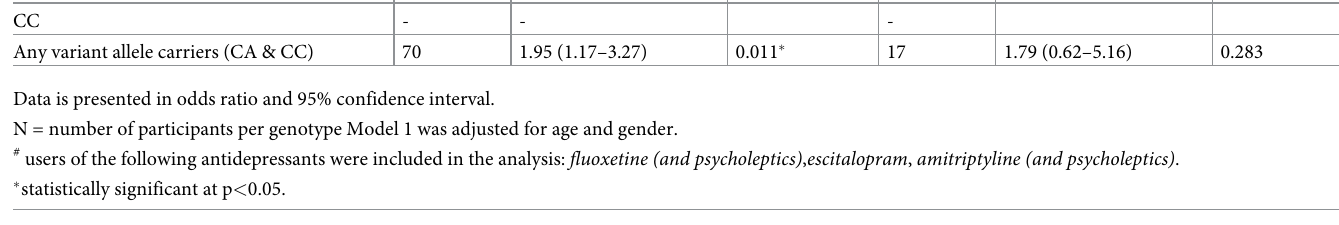
Table 4. Association between ABCB1 rs1045642 and rs1045642/rs1128503 haplotype and fall risk within antide- pressant users.